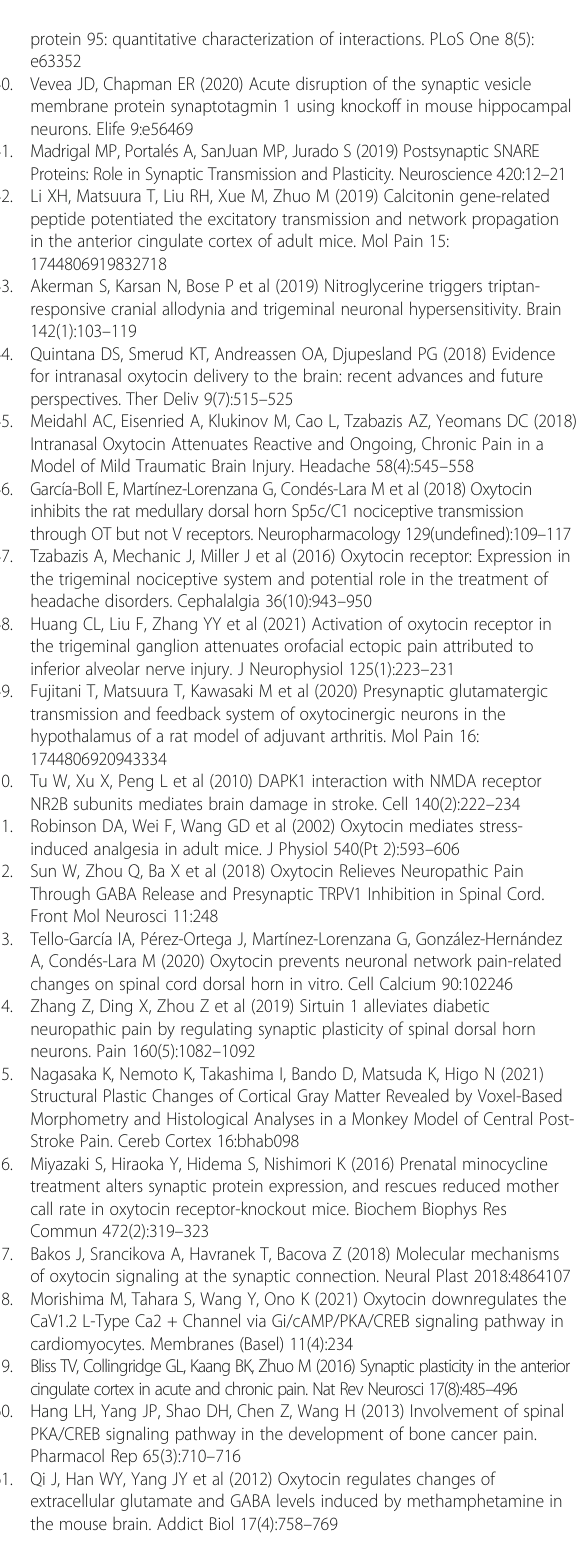
protein 95: quantitative characterization of interactions. PLoS One 8(5):